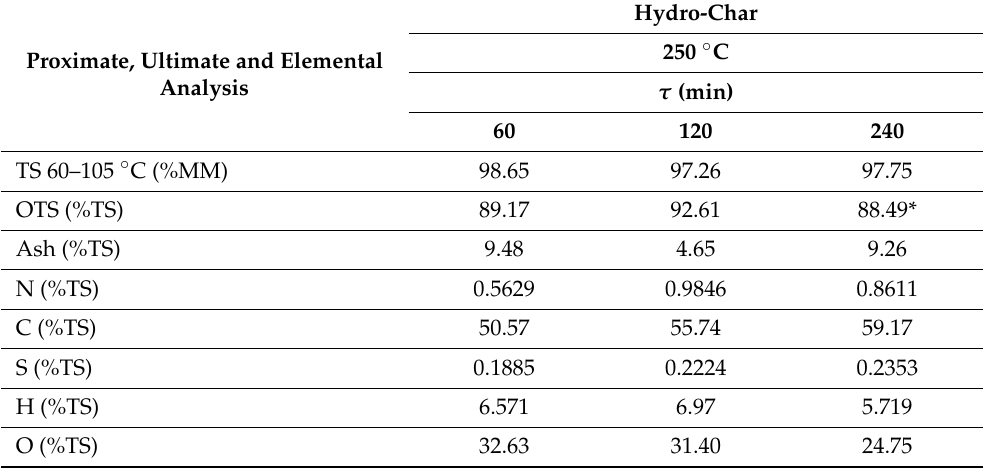
Table 3. Elemental characterization of hydro-char for reaction times of 60, 120 and 240 min.